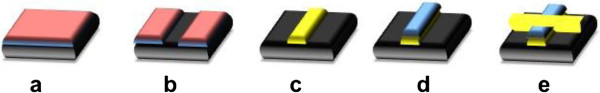
Scheme process flow for fabrication of crossbar molecular devices. (a) Photoresist patterning for bottom contacts on SiO2. (b) The 100-nm bar patterns were created using electron beam lithography. (c) Deposition of 10 nm of Ti and 150-nm Au over patterned substrate and lift-off excess Au with photoresist removal. (d) Deposition of SAM over the entire substrate. (e) Preparation and deposition of top electrodes.